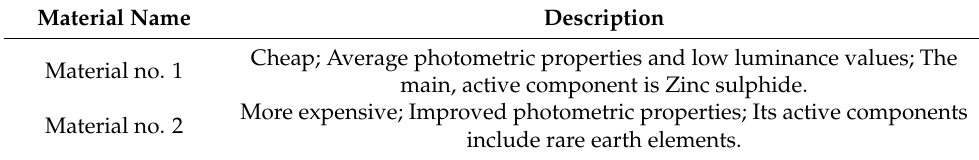
Table 1. Description of the materials used for the